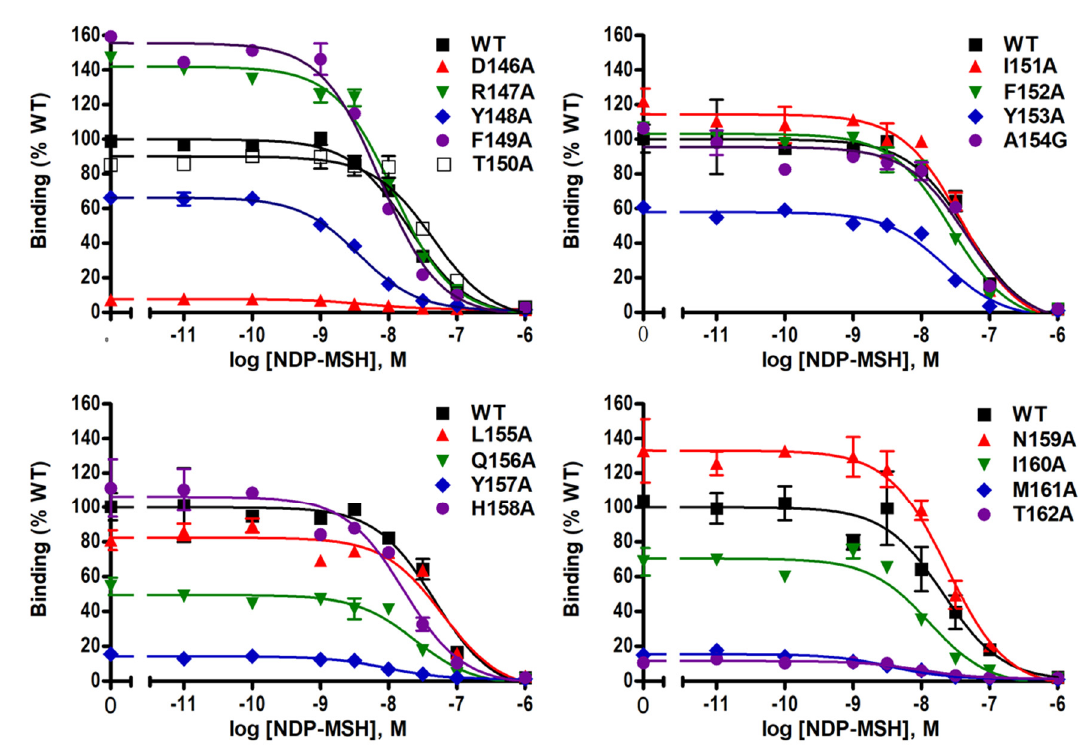
Figure 3. NDP-MSH binding properties of WT and mutant MC4Rs. HEK293T cells were transiently transfected with WT and mutant MC4Rs. Intact cell surface binding was measured by competitive inhibition of radiolabeled (iodine-125) NDP-MSH ([ 125 I]-NDP–MSH) with di ff erent concentrations of unlabeled NDP–MSH. Results are expressed as % of WT maximal binding ± S.E.M. of duplicate measurements within one experiment. Curves are representative of three independent experiments.